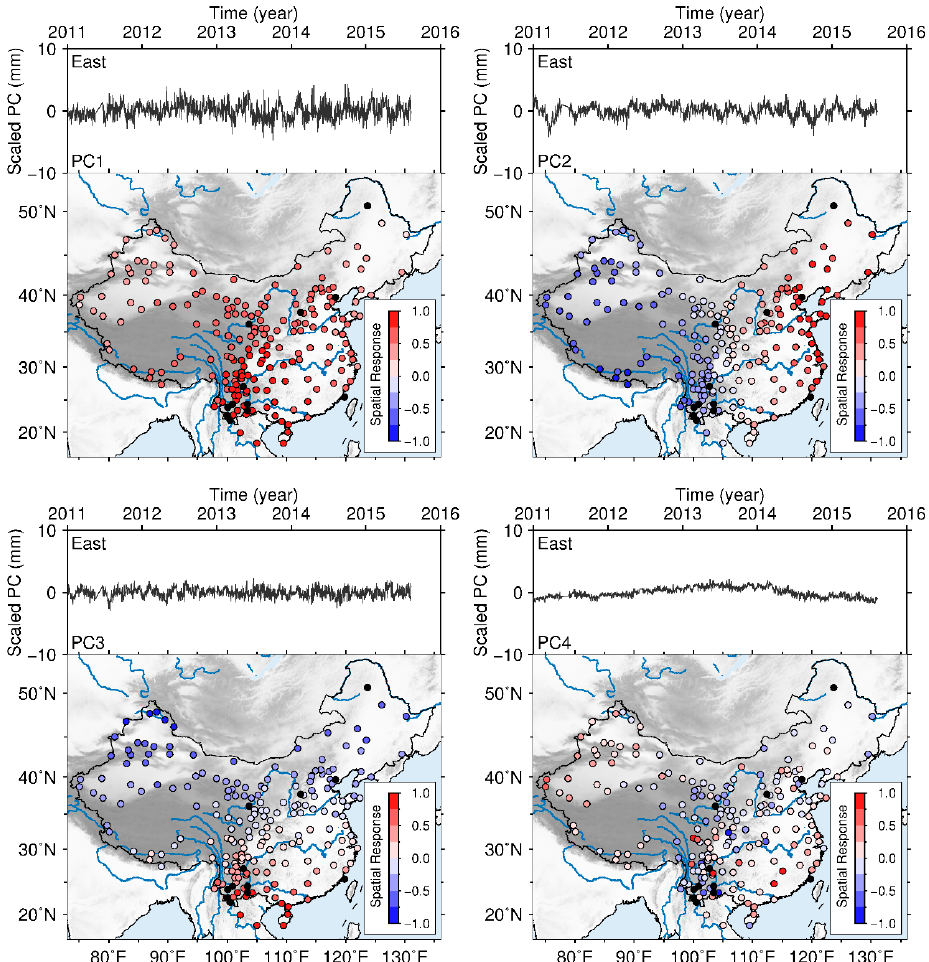
Figure A4. Same as Figure 4, but for the east component.